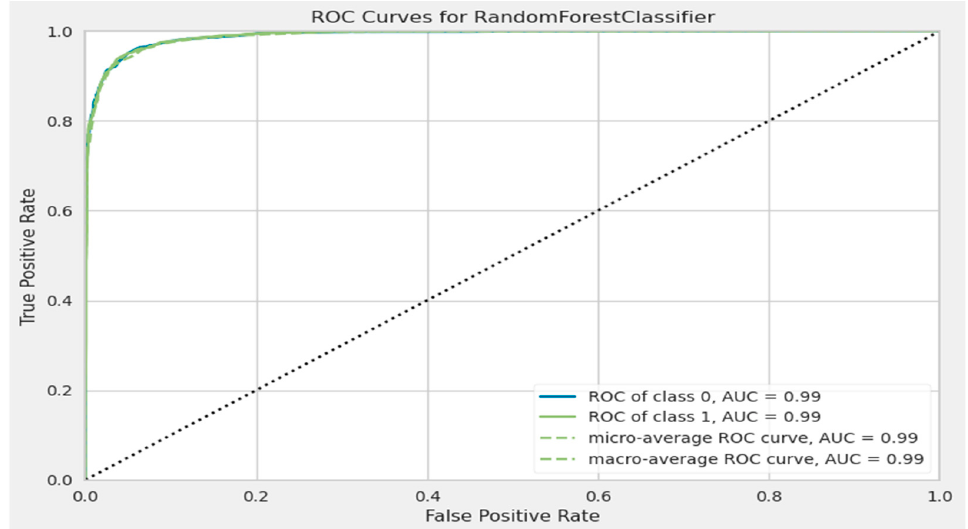
Figure 10. The ROC curve for the RF model after the hyper-parameter tuning.